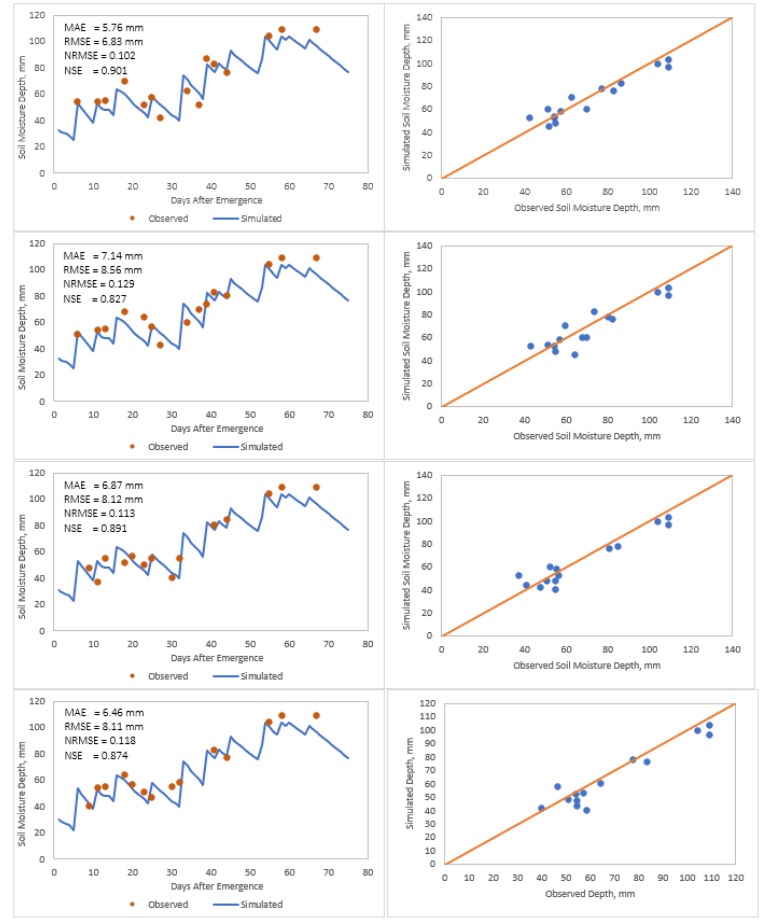
Figure 7. Simulated soil moisture depth using actual FC and PWP values and observed soil moisture depths from the four plots.